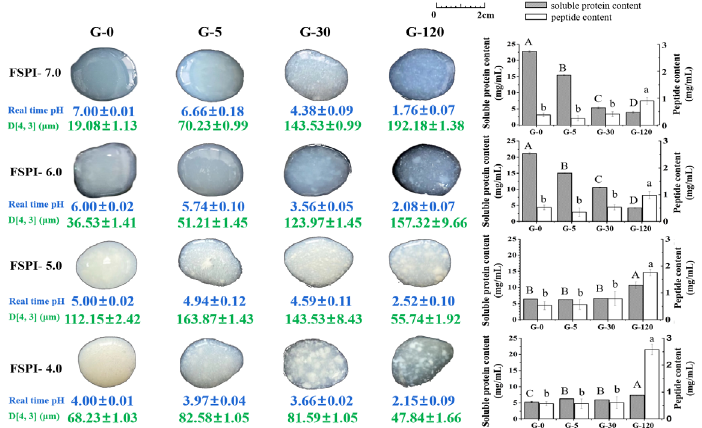
Figure 4. Intuitive images, D [4,3] value, real time pH, soluble protein, and peptide content of FSPI digestates collected during dynamic gastric digestion. G-5, G-30, and G-120 represent gastric digestion at 5, 30, and 120 min, respectively. Different letters indicated significant difference ( p < 0.05) between the FSPIs at different gastric digestion stages. Time is denoted by a star above the bars. Protein Particle